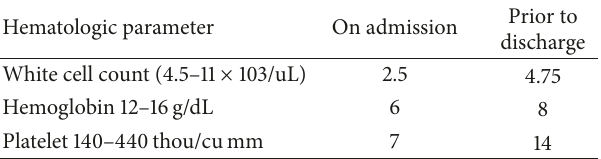
Table2:Completebloodcountonadmissionandpriortodischarge. Hematologic